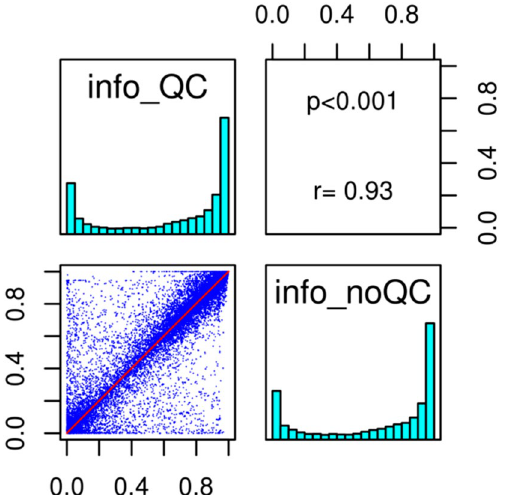
Figure 4. Correlation between information-impute2 scores obtained after QC pre-filtration (info_QC) and no QC variant filtration